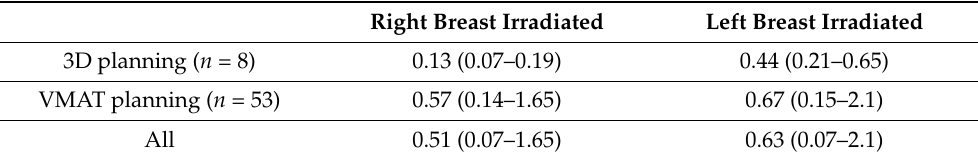
Table 3. Mean dose (and range) of radiation to the heart [Gy]. Right Breast Irradiated Left Breast Irradiated 3D planning ( n =